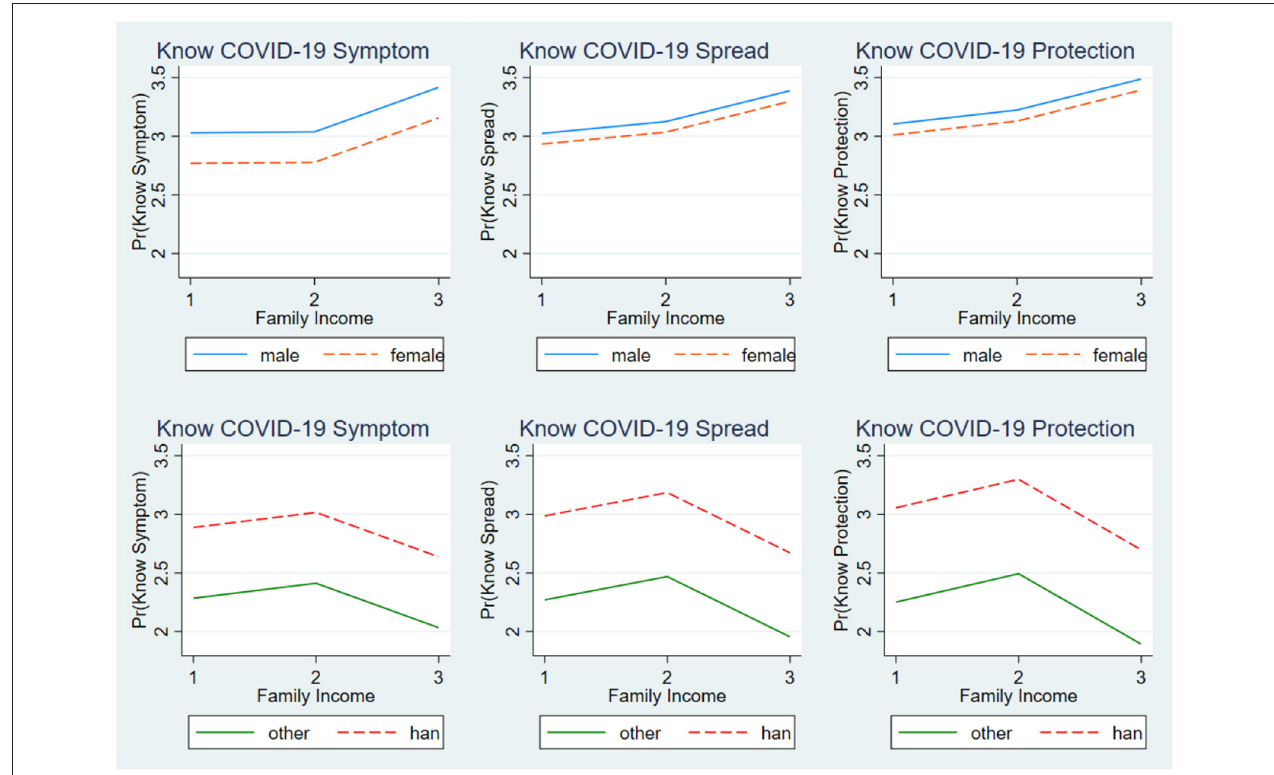
FIGURE 2 | The relationship between family income and students’ COVID-19 knowledge by sex and